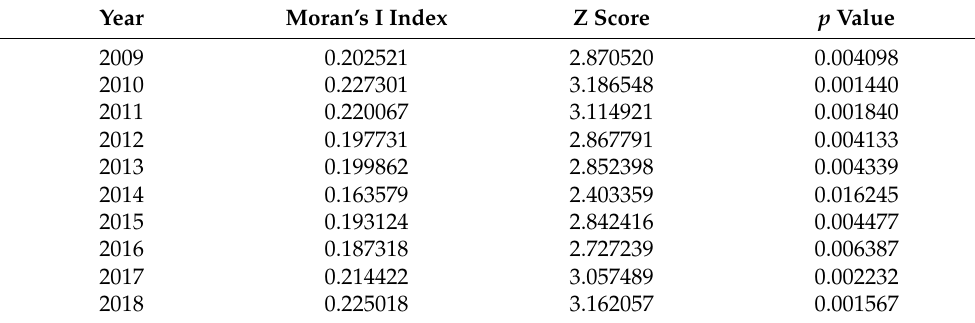
Table 2. Global Moran’s I value and test results of the tourism urbanization index of major tourist cities in